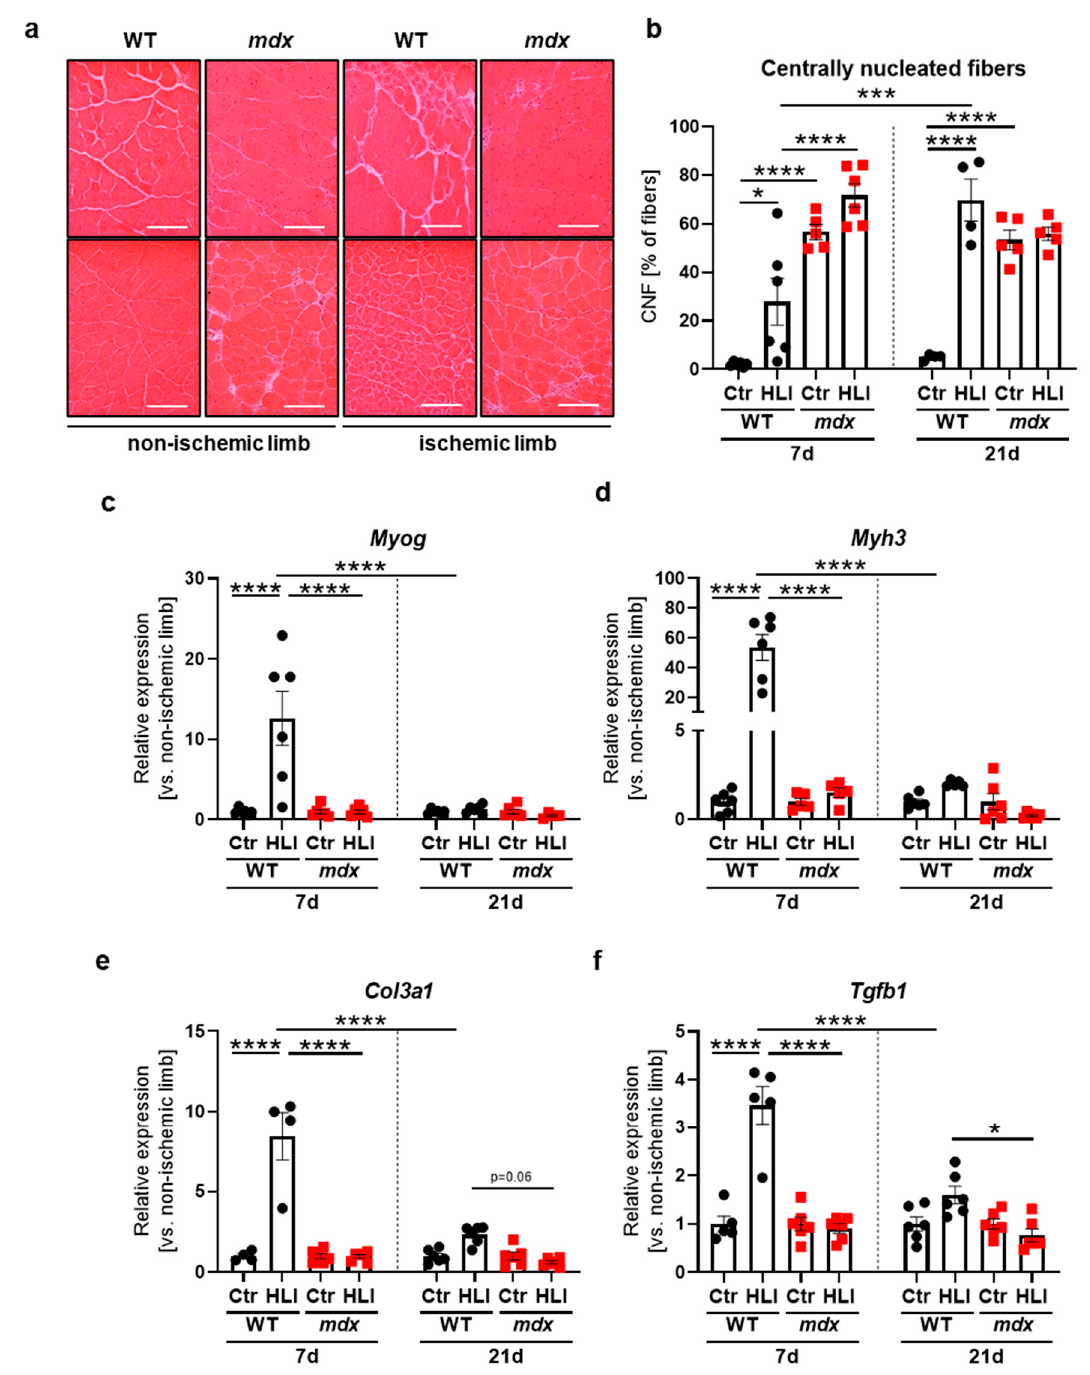
Figure 8. Regeneration and fibrotic markers following a hindlimb ischemia (HLI) procedure in 12-week-old WT and dystrophic animals. ( a ) Representative photos of H&E staining of centrally nucleated fibers in the non-ischemic (Ctr) and ischemic (HLI) tibialis anterior of WT and mdx mice 7 and 21 days after HLI together with ( b ) the calculated percentage of centrally nucleated fibers (CNF) among all fibers; representative pictures with a Nikon Eclipse microscope. Scale bar: 100 µ m; n = 4–6/group. ( c ) The expression of regenerative markers, Myog and ( d ) Myh3, as well as fibrotic factors ( e ) Col3a1 and ( f ) Tgfb1 in the non-ischemic limb and the ischemic limb of the gastrocnemius muscle from WT and mdx mice 7 and 21 days after HLI. qRT-PCR; n = 4–6/group. The results are presented as mean ± SEM. * p < 0.05, *** p < 0.005, **** p < 0.0001 by one-way ANOVA with Tukey’s posthoc test.